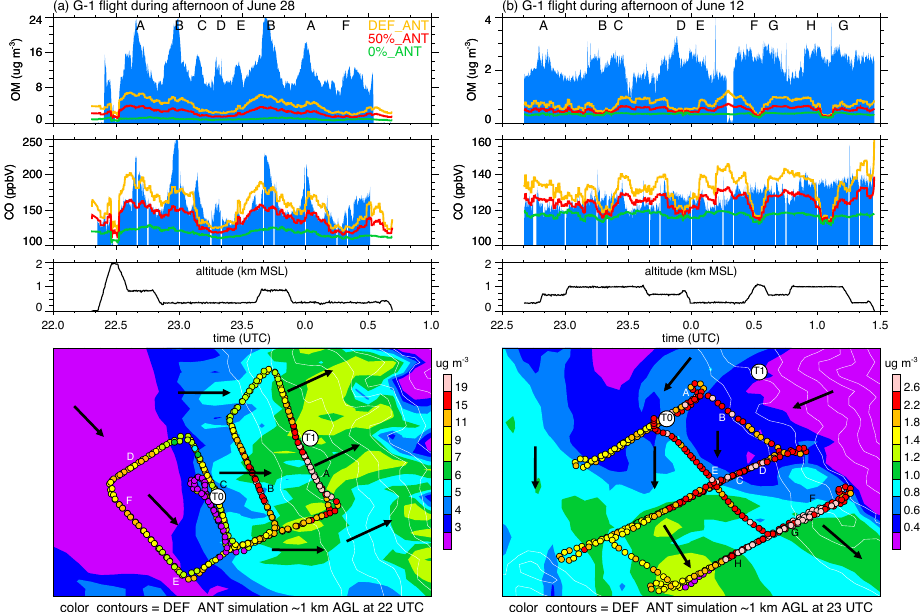
Figure 14. Observed and simulated OA during CARES in the vicinity of Sacramento for the afternoon of (a) 28 June and (b) 12 June. (a) and (b) represent days with high and low observed OA, respectively. Simulated OA is the total of the first four model size bins up to 0.625µm